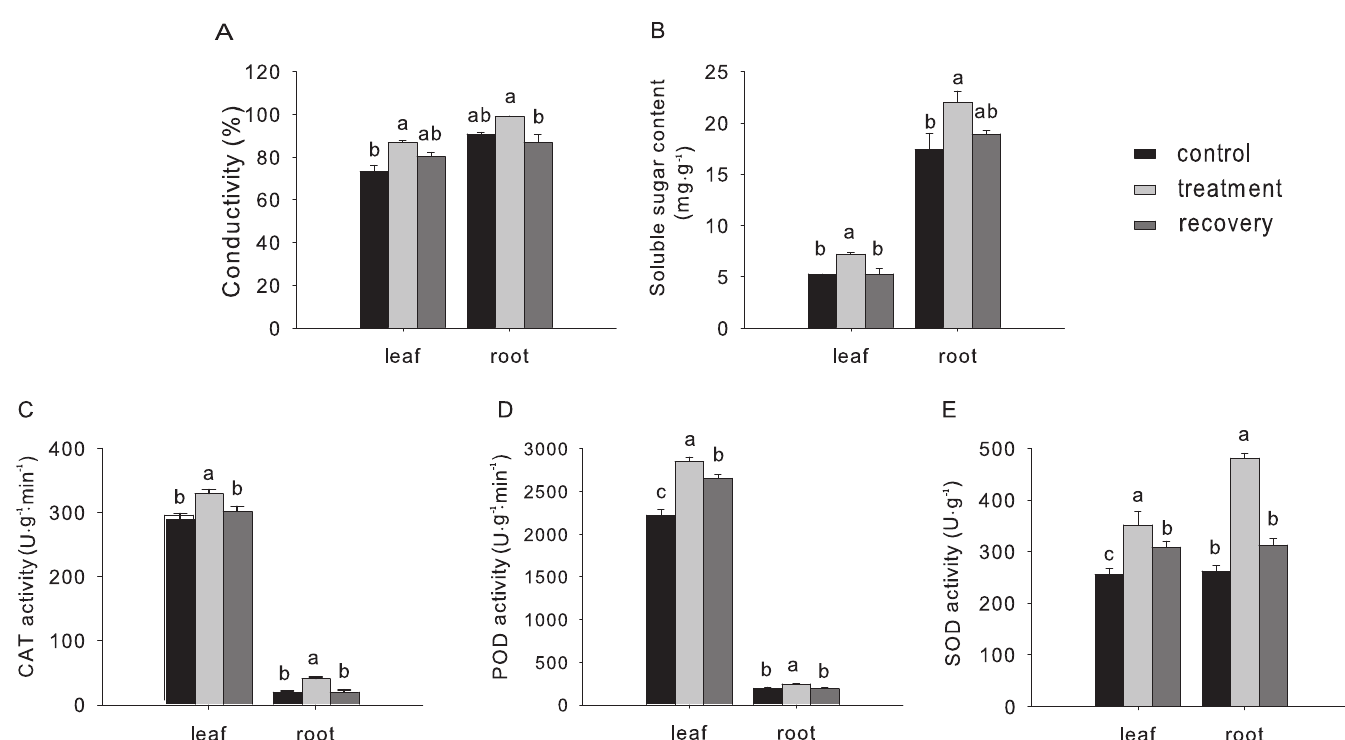
Fig 1. Effect of drought on physiological indexes of Medicago falcata . Different lower-case letters represent significant differences between different treatments ( P < 0.05).